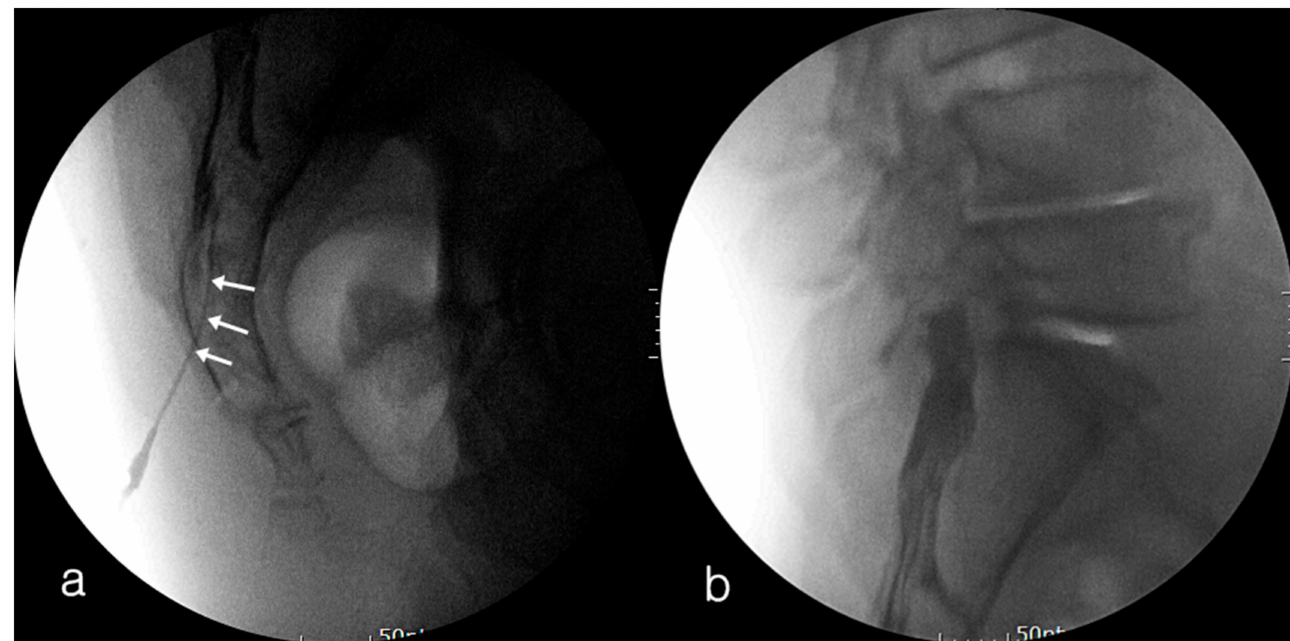
Figure 3. Fluoroscopic lateral images showing the contrast spread pattern through the 18-gauge, 1.88-inch catheter into the caudal epidural space. The outer catheter located within the sacral epidural space ( a ). The cephalic longitudinal spread of the contrast in caudal epidural space ( b ). Arrows indicate the outer